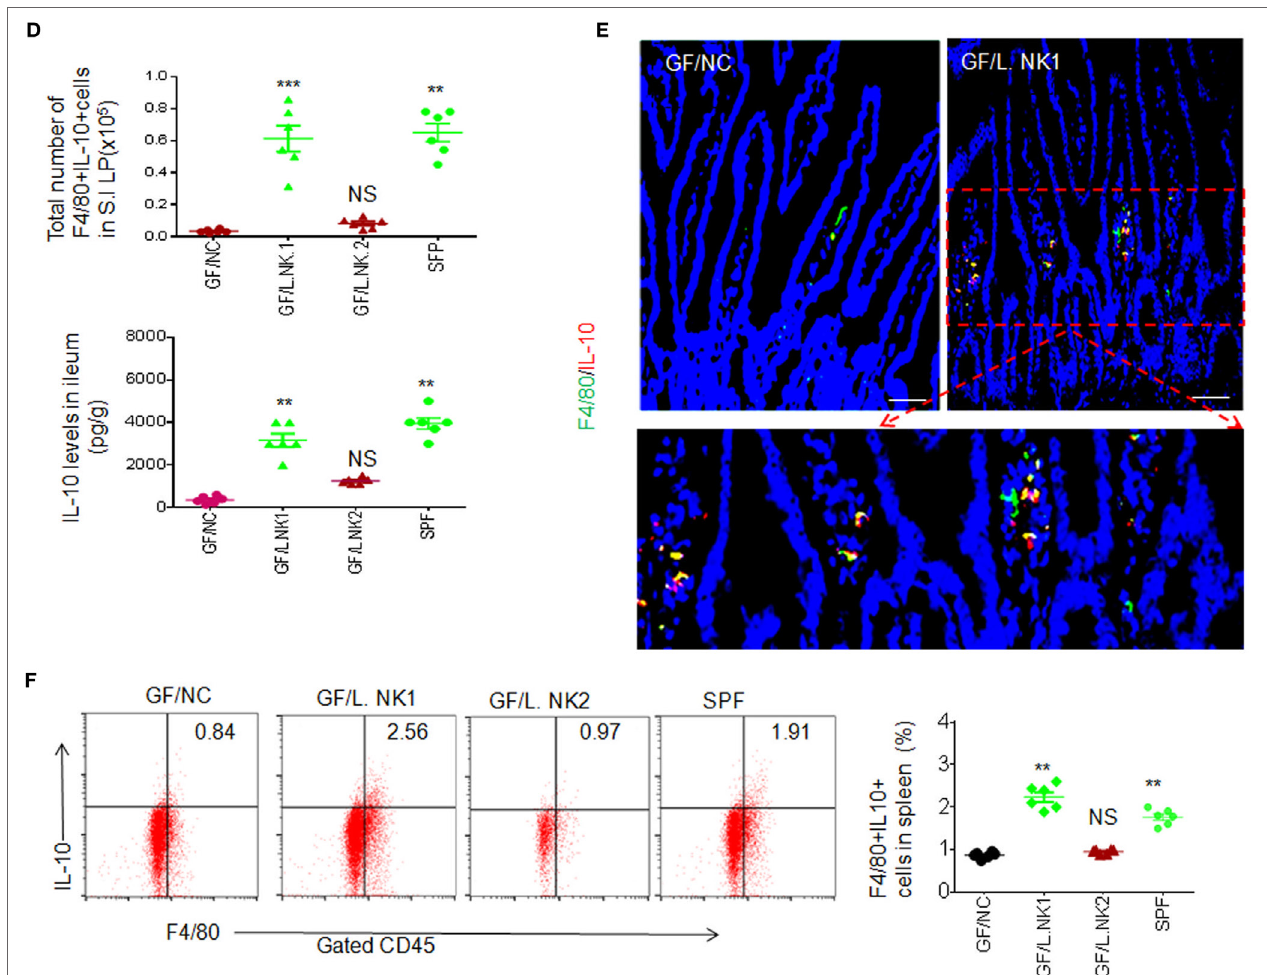
FigUre 2 | REG3 γ -associated lactobacillus induces accumulation of macrophages in germ-free (GF) mice. (a) Flow cytometry of macrophages in small intestinal lamina propria (LP) of GF mice with or without L.NK1 or L.NK2 colonization. The proportion of MHCII( + )F4/80( + ) macrophages in GF mice with (GF/L.NK1 or GF/L. NK2) and without (GF/NC) Lactobacillus colonization were compared (lower; n = 6). (B) Comparison of total MHCII( + )F4/80( + ) macrophages in whole small intestinal LP of GF mice with (GF/L.NK.1 or GF/L.NK2) and without (GF/NC) Lactobacillus colonization ( n = 6). (c) Flow cytometry of MHCII( + )F4/80( + ) macrophages in the PP and spleen of L.NK1 (GF/L.NK1) or L.NK2 (GF/L.NK2) colonized GF mice. The proportion of MHCII( + )F4/80( + ) macrophages in GF mice with (GF/L.NK.1 or GF/L.NK2) and without (GF/NC) Lactobacillus colonization were compared (right; n = 6). (D) Comparison of total F4/80( + )IL-10( + ) macrophages (upper) and interleukin (IL)-10 levels (lower) in the whole small intestinal LP of GF mice with (GF/L.NK.1 or GF/L.NK2) or without (GF/NC) Lactobacillus colonization ( n = 6). (e) Immunostaining of F4/80( + )IL-10( + ) macrophages in the ileum tissues with or without L.NK.1 colonization. The representative images of six mice per group; scale bars = 40 μ m. (F) Flow cytometry of F4/80( + )IL-10( + ) macrophages in the spleen of L.NK.1 (GF/L.NK.1) or L.NK.2 (GF/L.NK2) colonized GF mice. The proportion of F4/80( + )IL-10( + ) macrophages in GF mice with (GF/L.NK.1 or GF/L.NK2) and without (GF/NC) Lactobacillus colonization were compared (right; n = 6). Specific pathogen-free (SPF), wt mice raised in SPF environment; * p < 0.05, ** p < 0.01, and *** p < 0.001 (one-way analysis of variance, mean ± SD). See